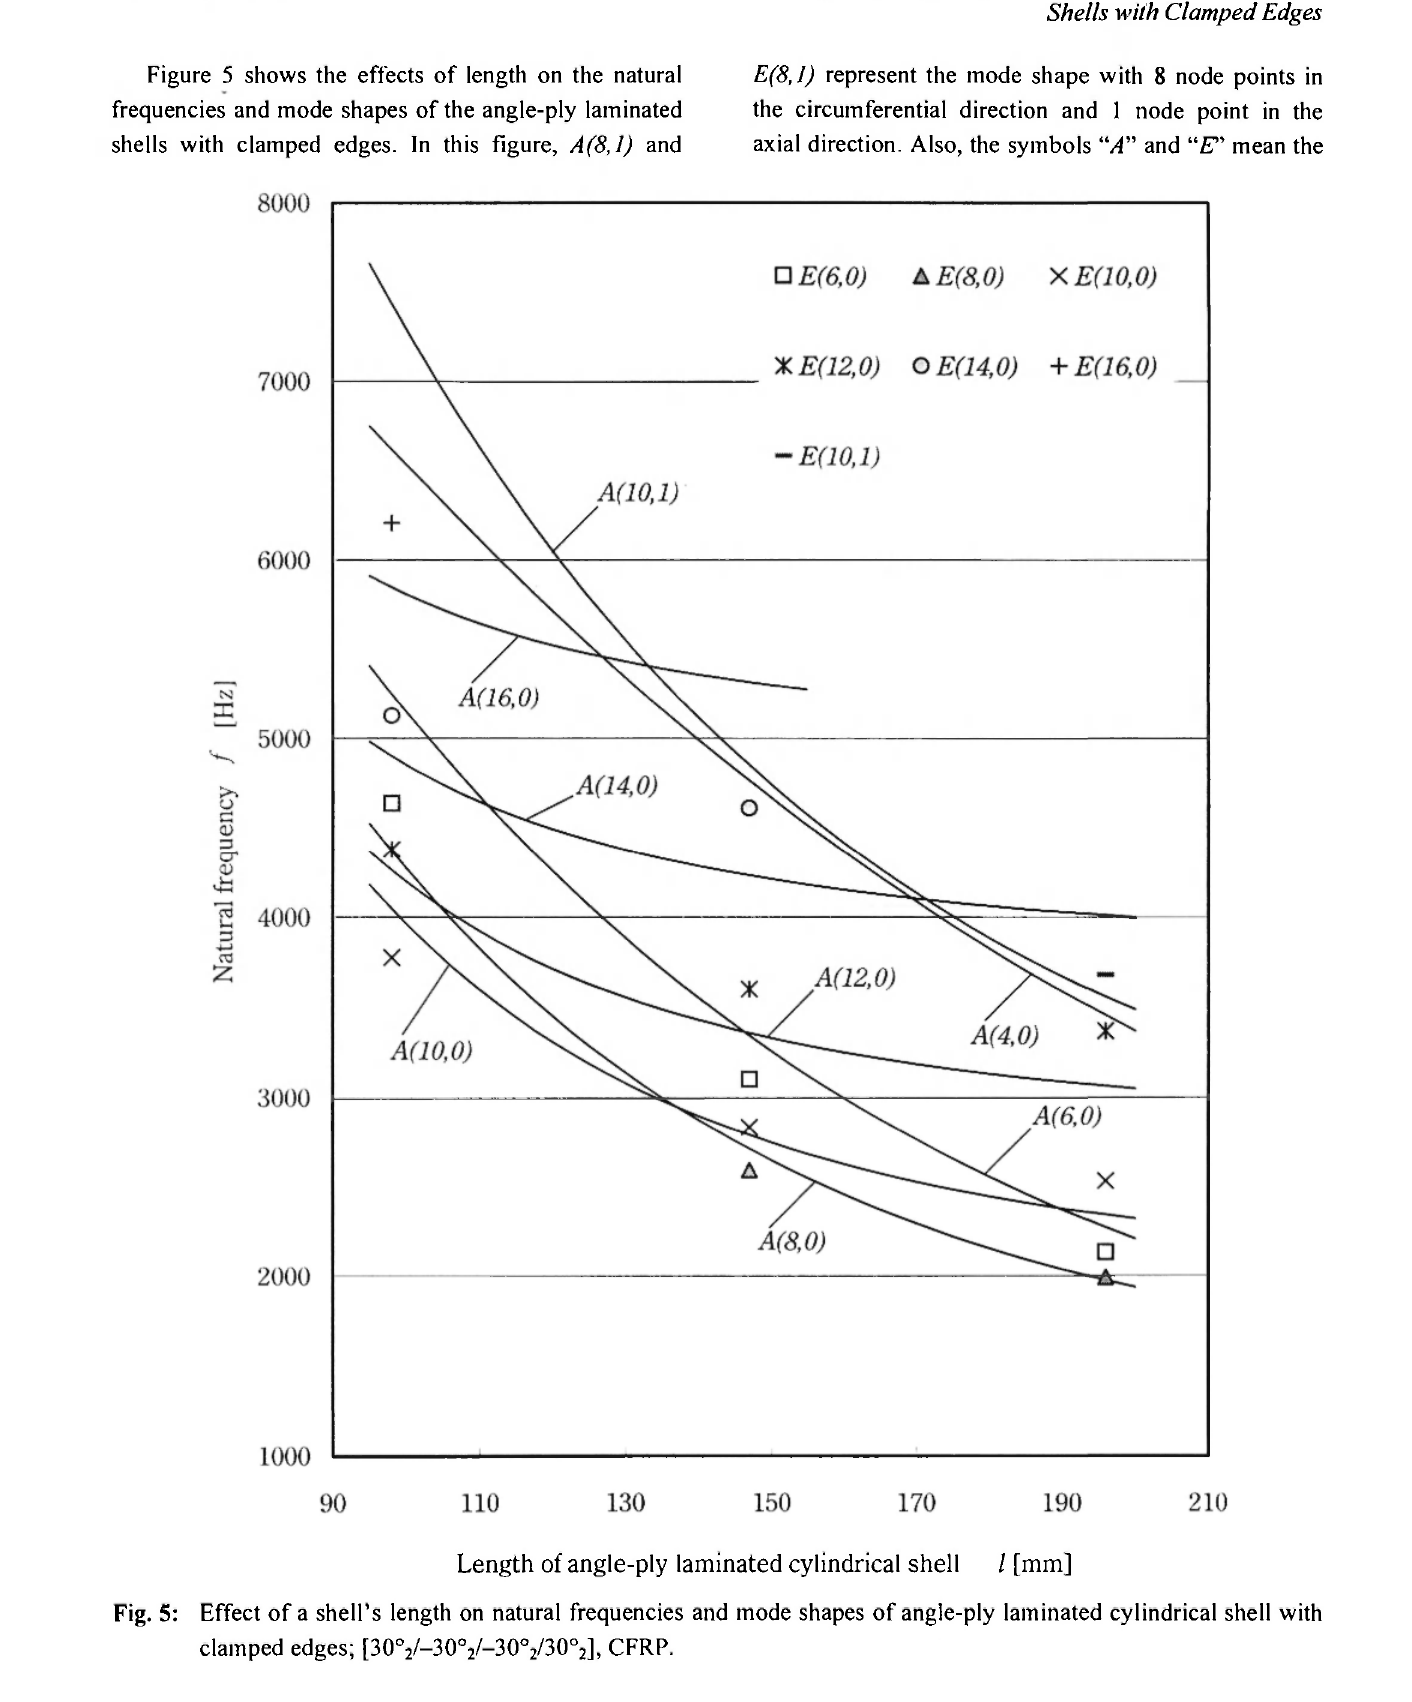
Fig. 5: Effect of a shell's length on natural frequencies and mode shapes of angle-ply laminated cylindrical shell with clamped edges; [30° 2 /-30 ο 2 /-30 ο 2 /30 ο 2 ],